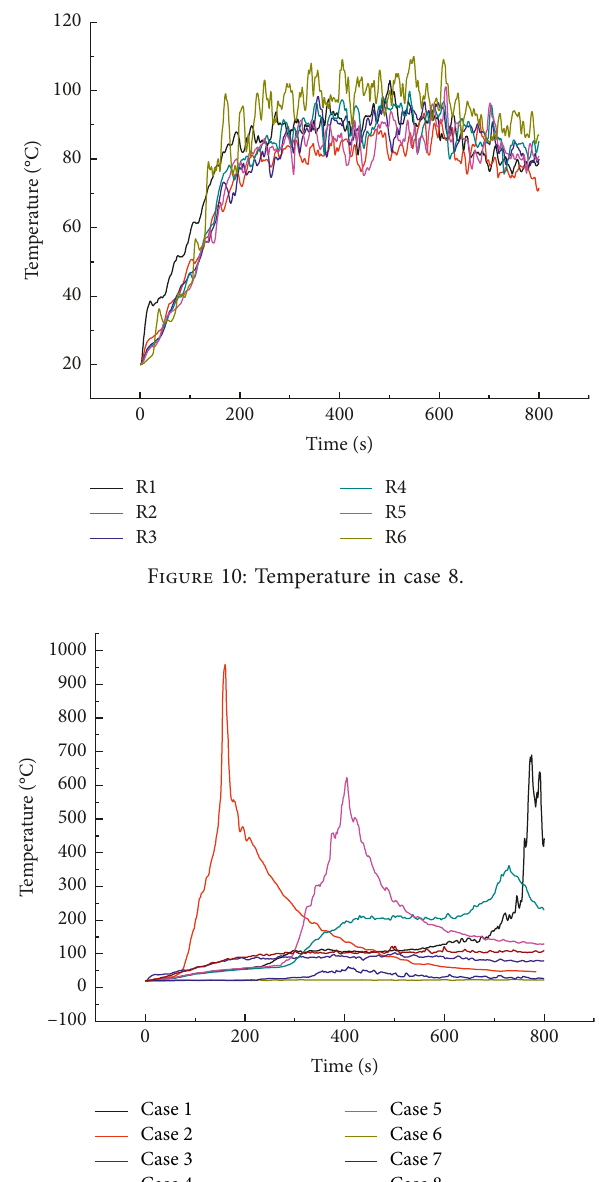
Figure 11: Comparison of maximum temperature in eight